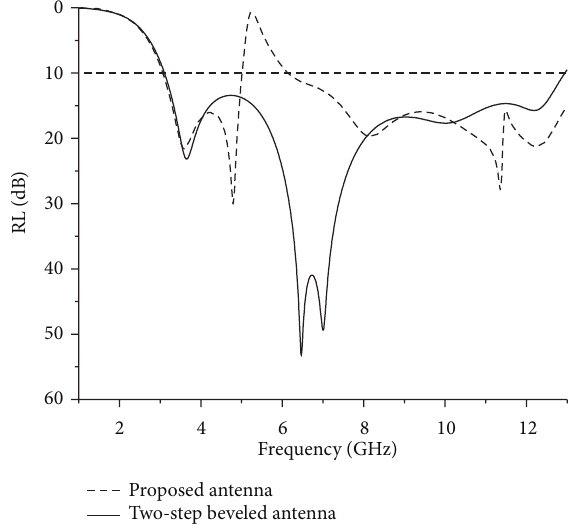
Figure 2: Return loss versus frequency (solid line: the two-step beveled antenna and dash line: the proposed